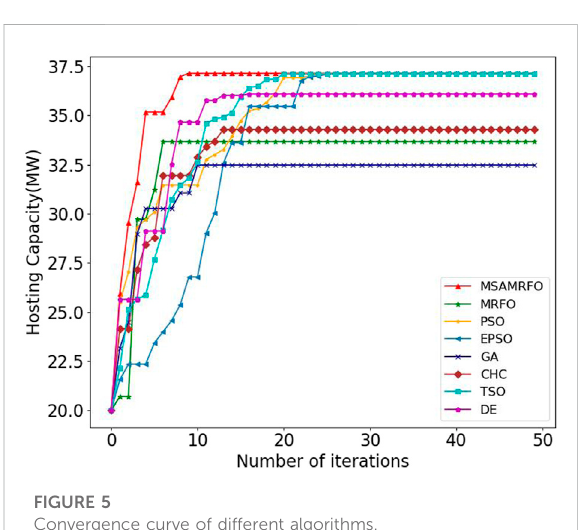
FIGURE 5 Convergence curve of different